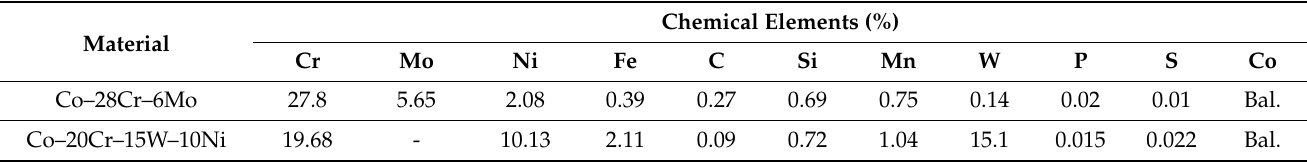
Table 1. Chemical composition of the CoCrMo and CoCrWNi